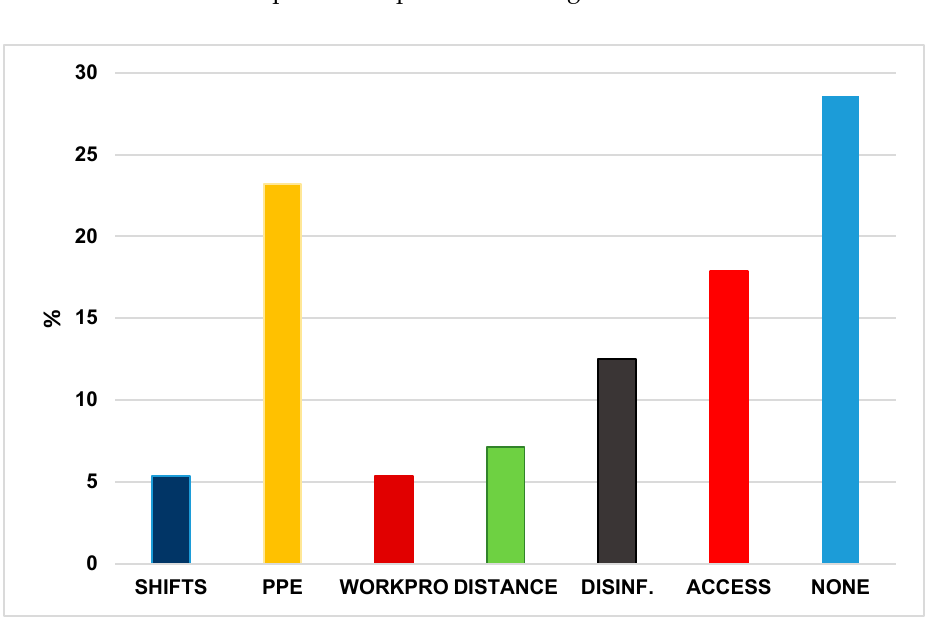
Figure 9. Responses of workers to the open question (percentages).